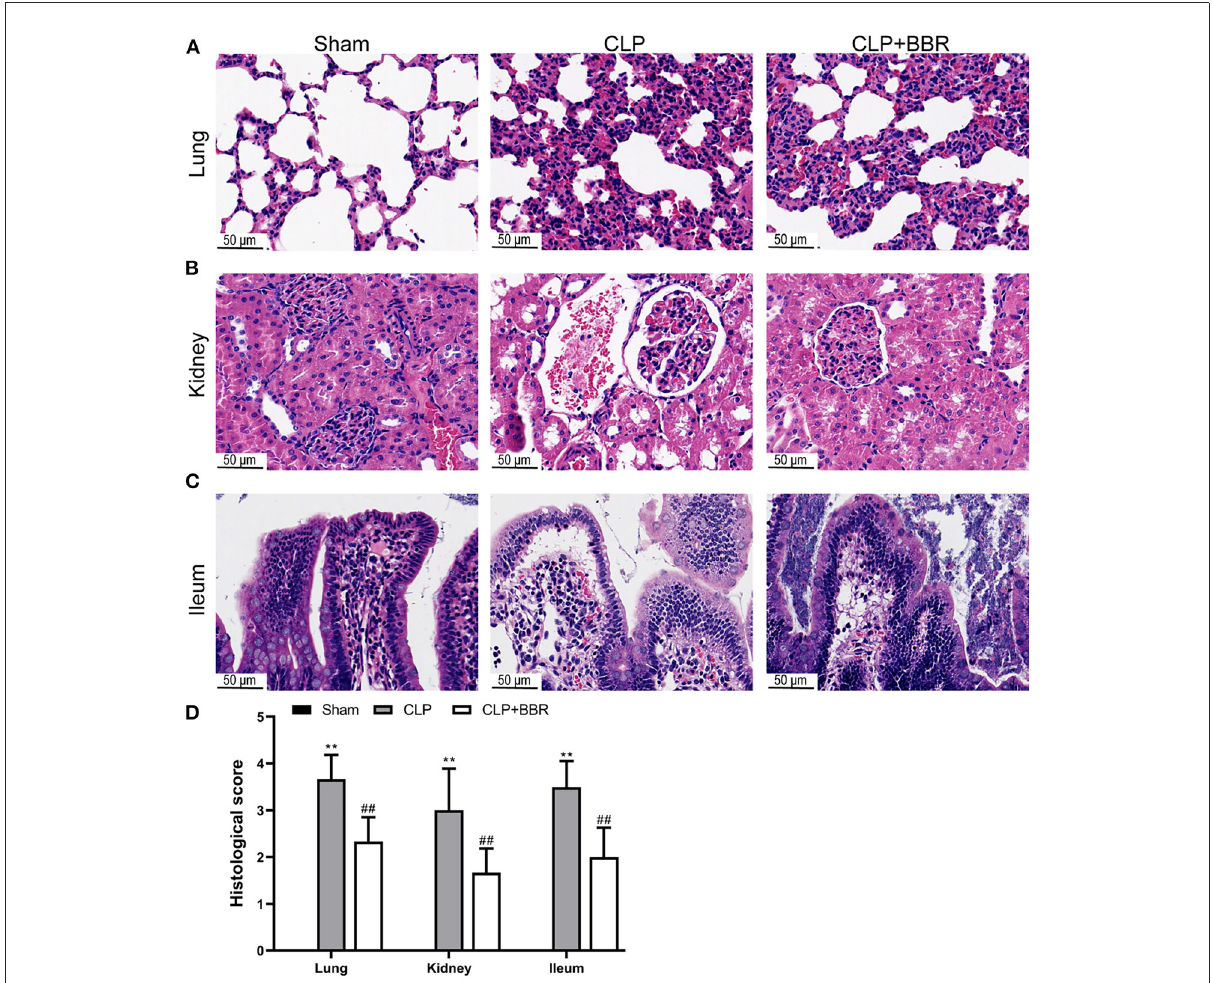
FIGURE1 Histological observation of cecal ligature and puncture (CLP) rats by hematoxylin-eosin staining. Berberine treatment on sepsis improved the histological damage of (A) lung, (B) kidney, and (C) ileum, scale bars = 50 µ m. Also, berberine treatment on sepsis decreased (D) histological scores of the lung, kidney, or ileum ( n = 6). Data are shown as mean ± standard deviation. ** p < 0.01 vs. sham group; ## p < 0.01 vs. CLP